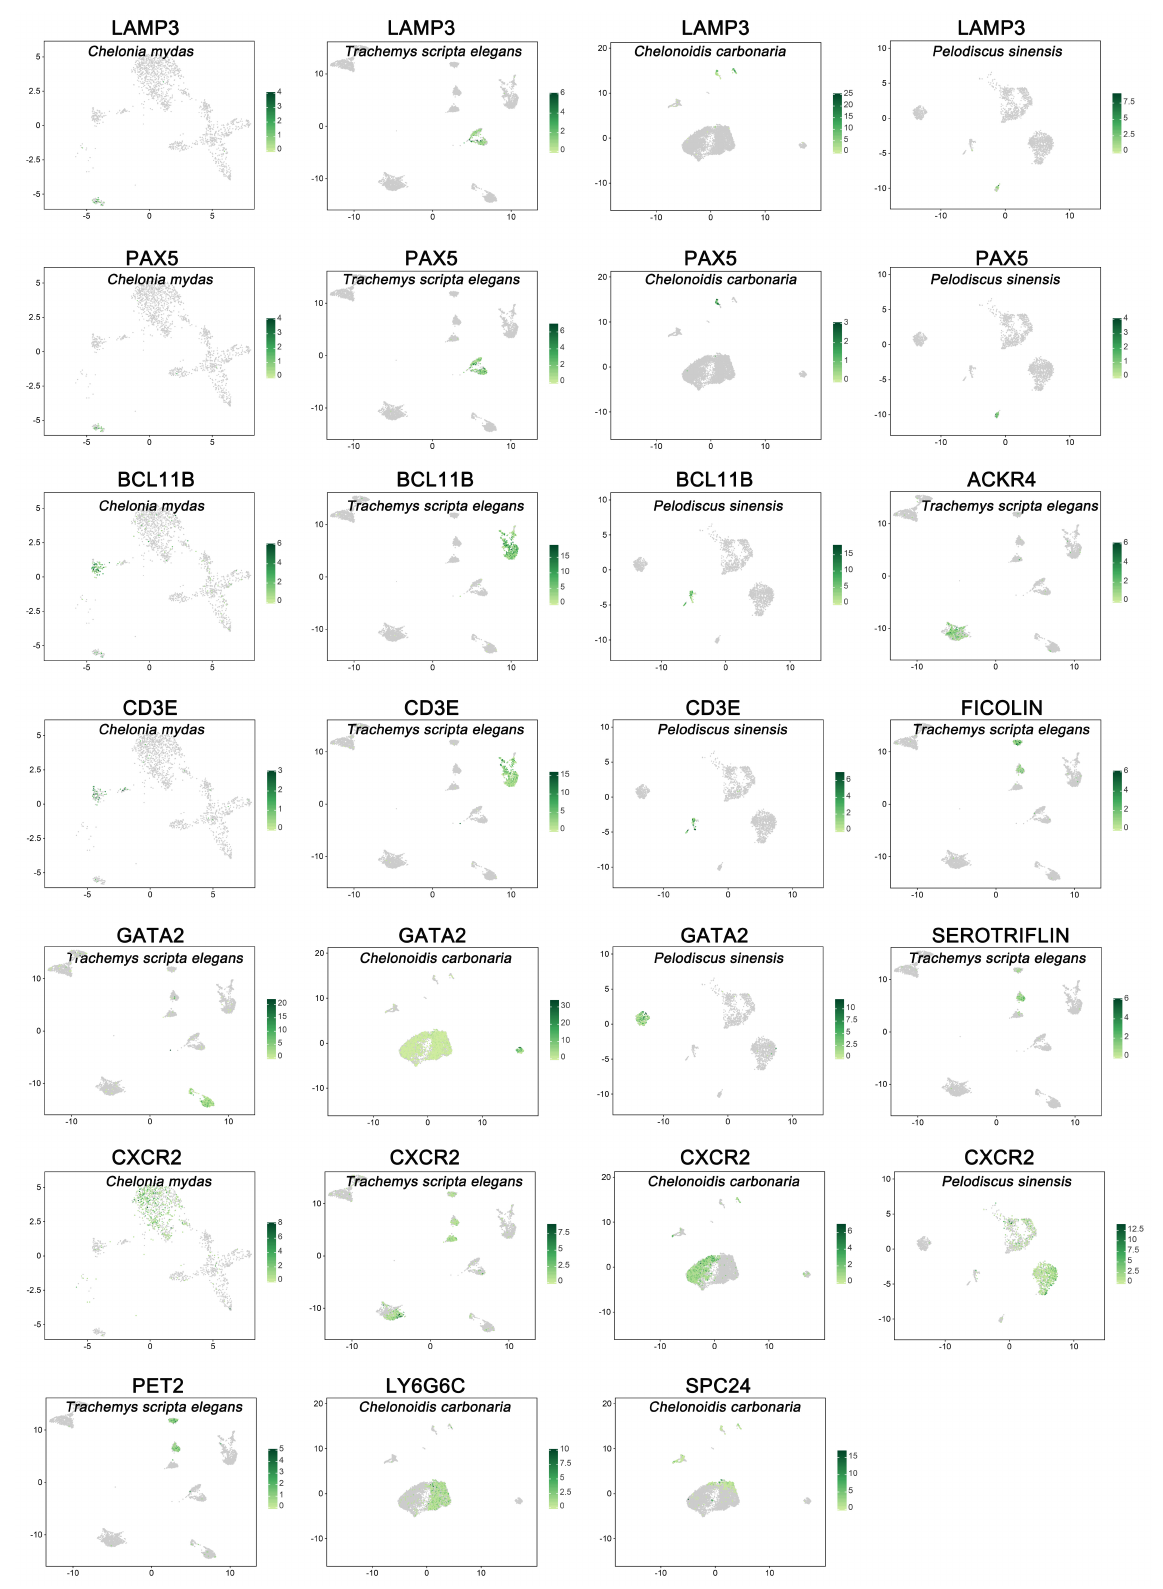
Figure 2. Canonical cell markers were used to label clusters by cell identity as represented in the UMAP